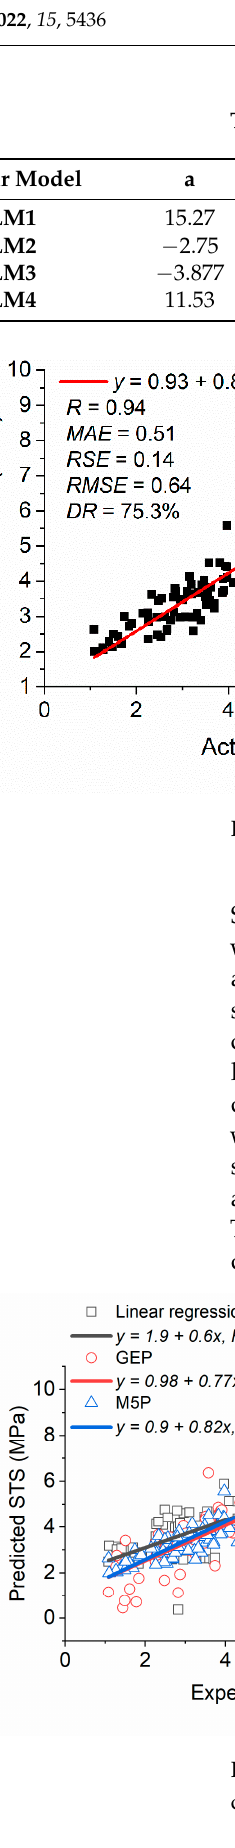
Figure 9. Comparison of the linear regression analysis, GEP, and M5P for the prediction of STS of concrete made with SF: ( a ) training set; ( b ) testing set. Table 6. Comparison of the different models developed for the STS database.